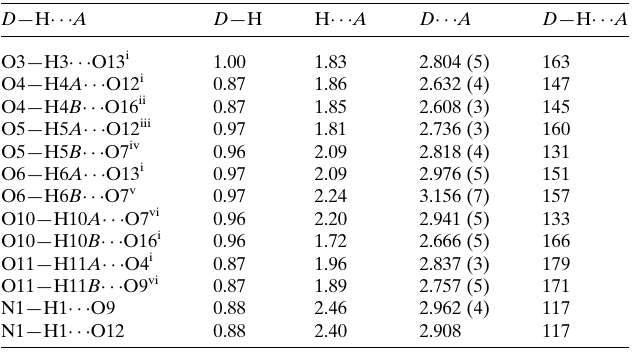
Table 1 Hydrogen-bond geometry (A˚ , (cid:4)